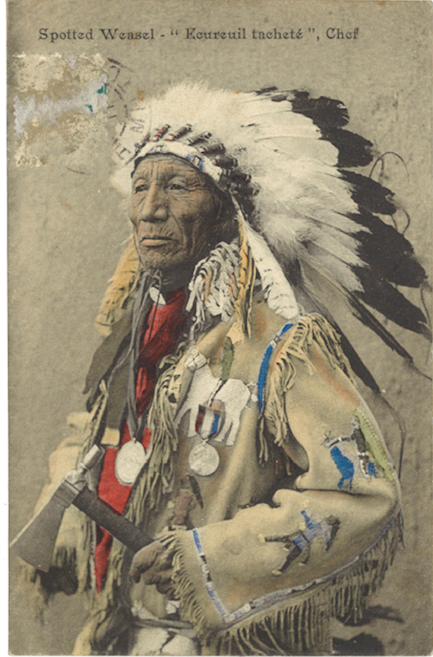
Figure 14. Postcard of It ȟ ú ŋ kasa ŋ Glešká, Paris, 1911, Collection of Didier Lévêque, Paris. Photograph used by permission of the owner.